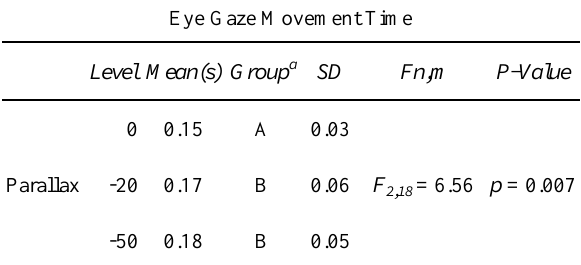
Means, SDs, ANOVA, and Tukey HSD test results of eye gaze movement time Eye Gaze Movement